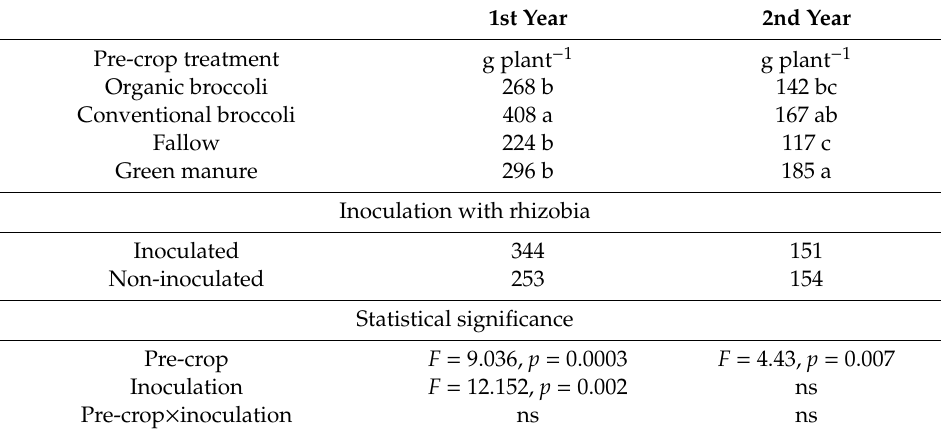
Table 3. Impact of di ff erent pre-crop treatments during the cold season and inoculation with Rhizobium tropici CIAT 899 on shoot fresh weight (SFW) of the common bean at the 50% flowering stage in both experimental years.